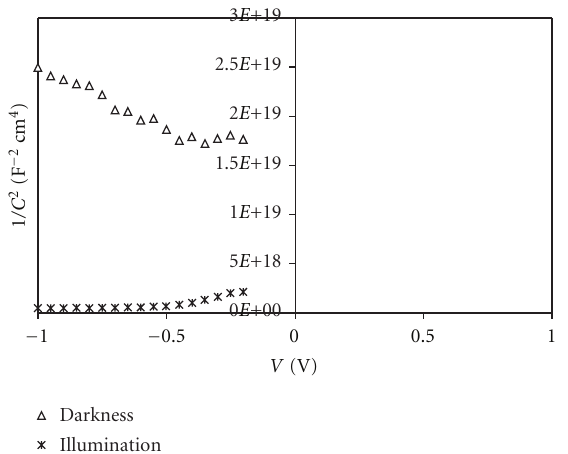
Figure 4: Mott-Schottky plots for Al/PANI-DBSA/n-Si/Au hetero- junctions under darkness and illumination (0.09W/cm 2 ).